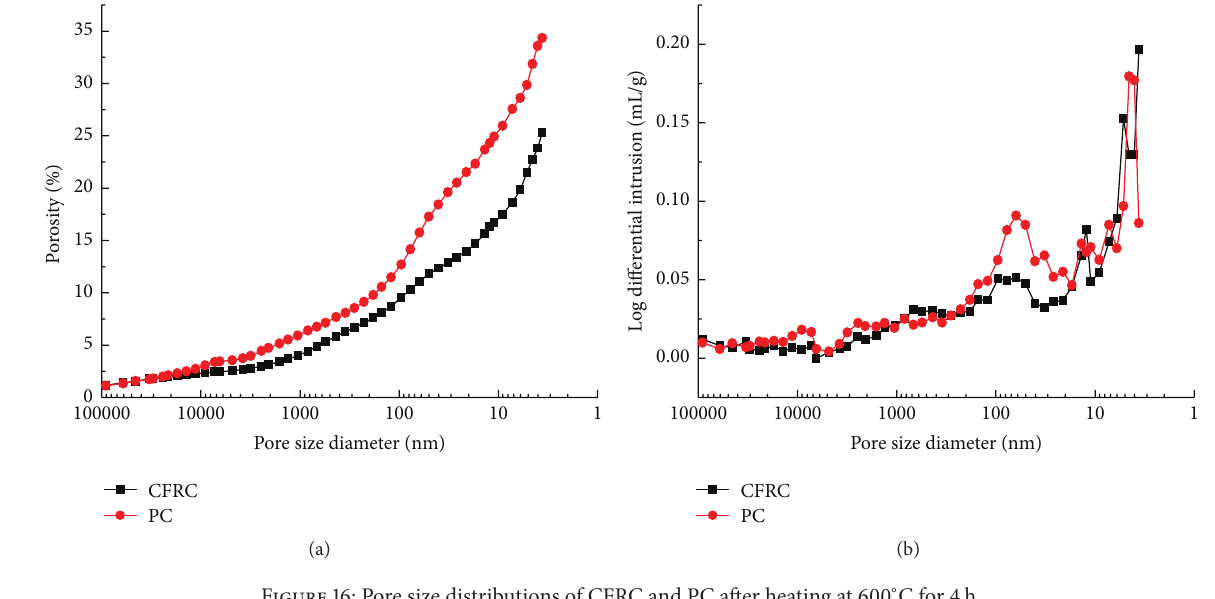
Figure 16: Pore size distributions of CFRC and PC after heating at 600 ∘ C for 4h.